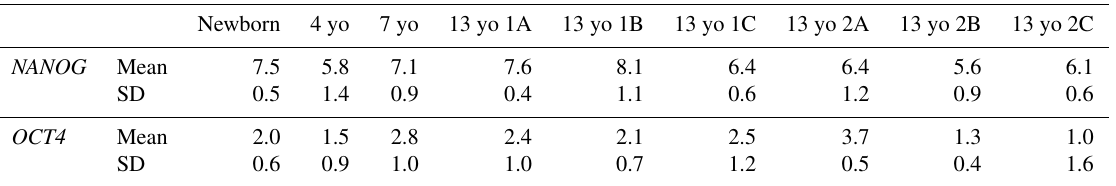
Table 1. Expression of pluripotency genes NANOG and OCT4 in marmoset iPS cell clones. The designation of the clones – derived from a newborn, a 4-year-old, a 7-year-old and two 13-year-old marmosets – is as described in the text. The values are given as Ct(gene) – Ct( β -actin). Note that lower numerical values represent higher mRNA levels.